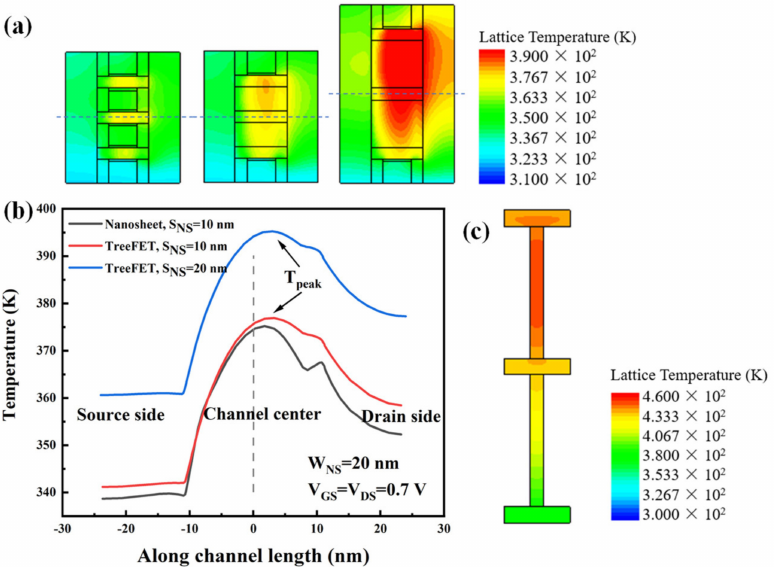
Figure 11. ( a ) Thermal distribution of 3-stacked nanosheet FET/TreeFET (S NS = 10/20 nm) at W IB = 5 nm; ( b ) lattice temperature distribution curve along channel length of middle NS; ( c ) thermal distribution of channel cross sections with W IB = 4 nm, S NS = 40 nm at V GS = V DS = 0.7 V. Figure 12a,b show T L, MAX and R th (defined by R th = (T L, MAX − T ambient )/(V DS × I DS ), T ambient = 300 K) of different S NS at W IB = 3/4/5 nm. It can be seen that T L, MAX increases with the increase in S NS and the decrease in W IB , which is mainly due to the increase in I ON . As the W IB decreases, the thermal resistance increases due to the intensified phonon-boundary scattering, while as the W IB increases, the cross-sectional area of the IB increases, which improves the heat dissipation towards BEOL and increases the heat flux exchange among channels.